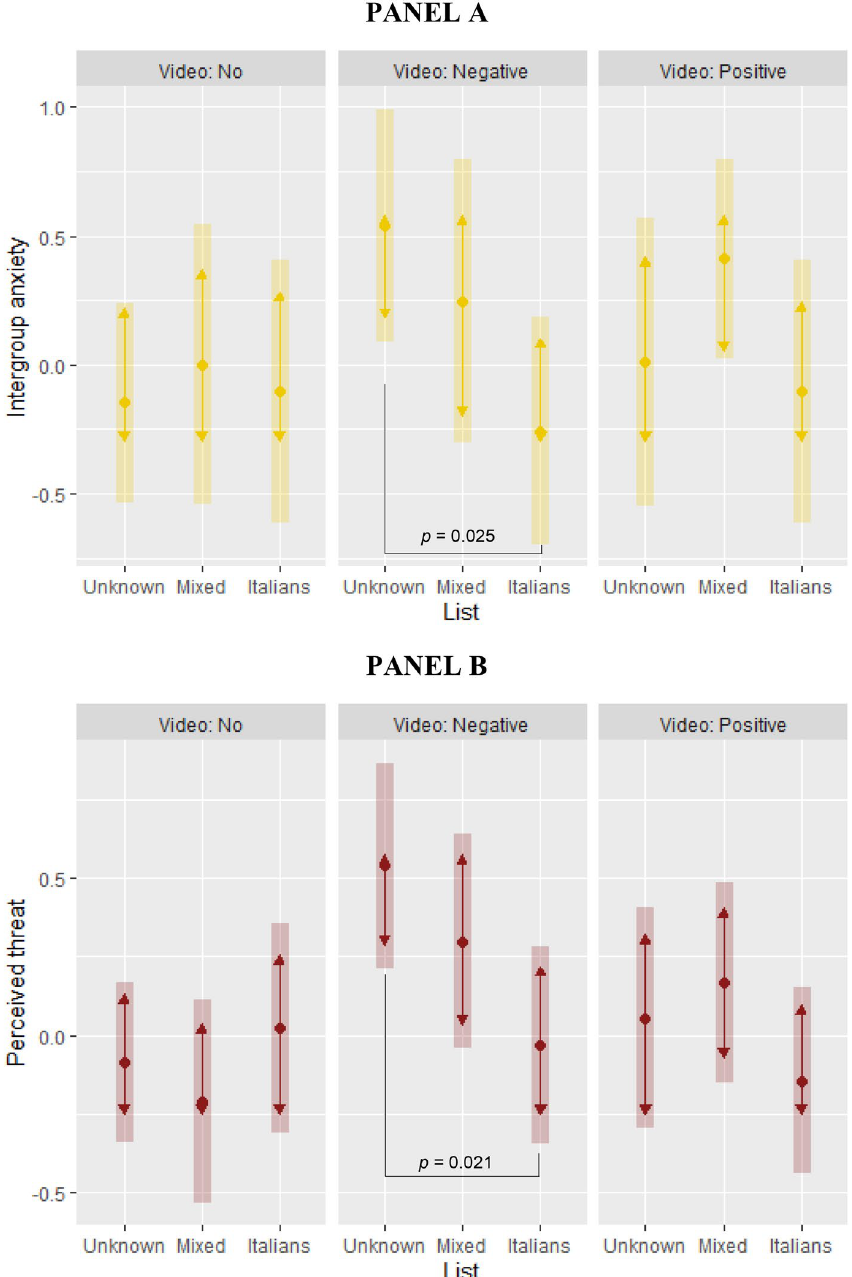
Figure 4. The effects of media portrayals of immigrants on intergroup anxiety and perceived outgroup threat (Study 2). Estimated marginal means of intergroup anxiety ( A ) and perceived outgroup threat ( B ) by video and list conditions (Tukey adjustment for contrasts; bars: 95% confidence intervals; non-overlapping arrows: statistically significant pairwise comparison, p < 0.05). Intergroup anxiety: first extracted component from a principal component analysis on answers to six questions measuring intergroup anxiety 22 . Perceived outgroup threat: first extracted component from a principal component analysis on answers to five questions measuring perceived outgroup threat 20 . Sample: Study 2